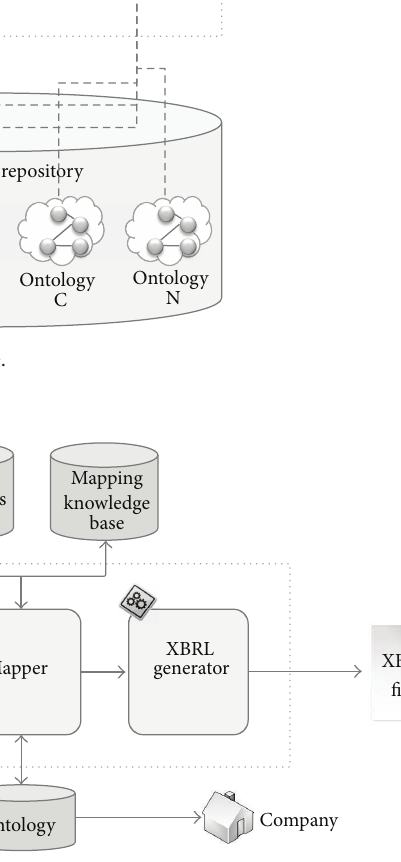
Figure 9: Architecture of XBRL